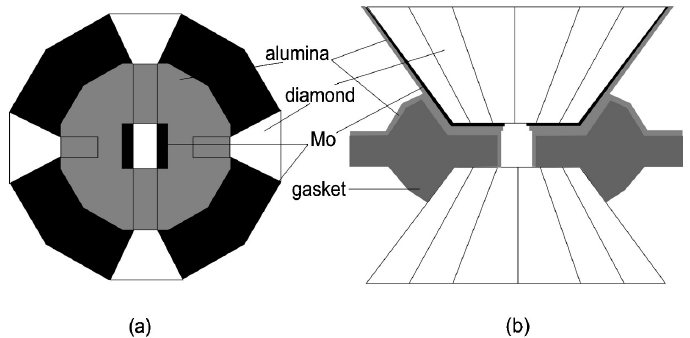
Figure 2. ( a ) Configuration of a microcircuit on a diamond anvil [40]. ( b ) Diagram of a microcircuit in a diamond anvil cell [40].